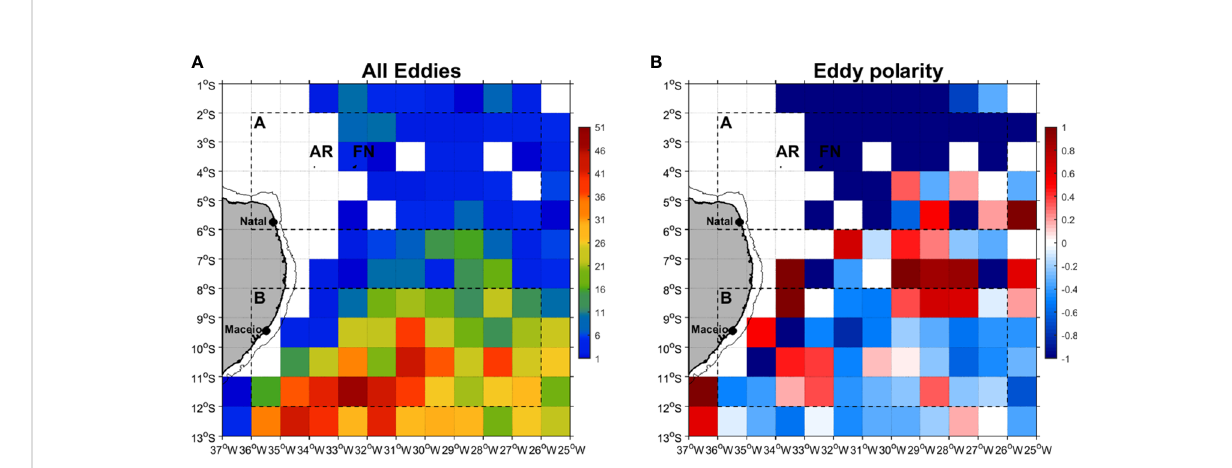
FIGURE 2 Spatial distribution of mean annual number of detected eddies per degree square over 1993-2018 period: (A) all eddies, (B) eddy polarity. The dashed rectangles delimit the northern (region A) and southern (region B) part of the NEB. The northern region A includes the Atoll das Rocas (AR) and Fernando de Noronha (FN) archipelago. The black solid line indicates the bathymetric contour at 70